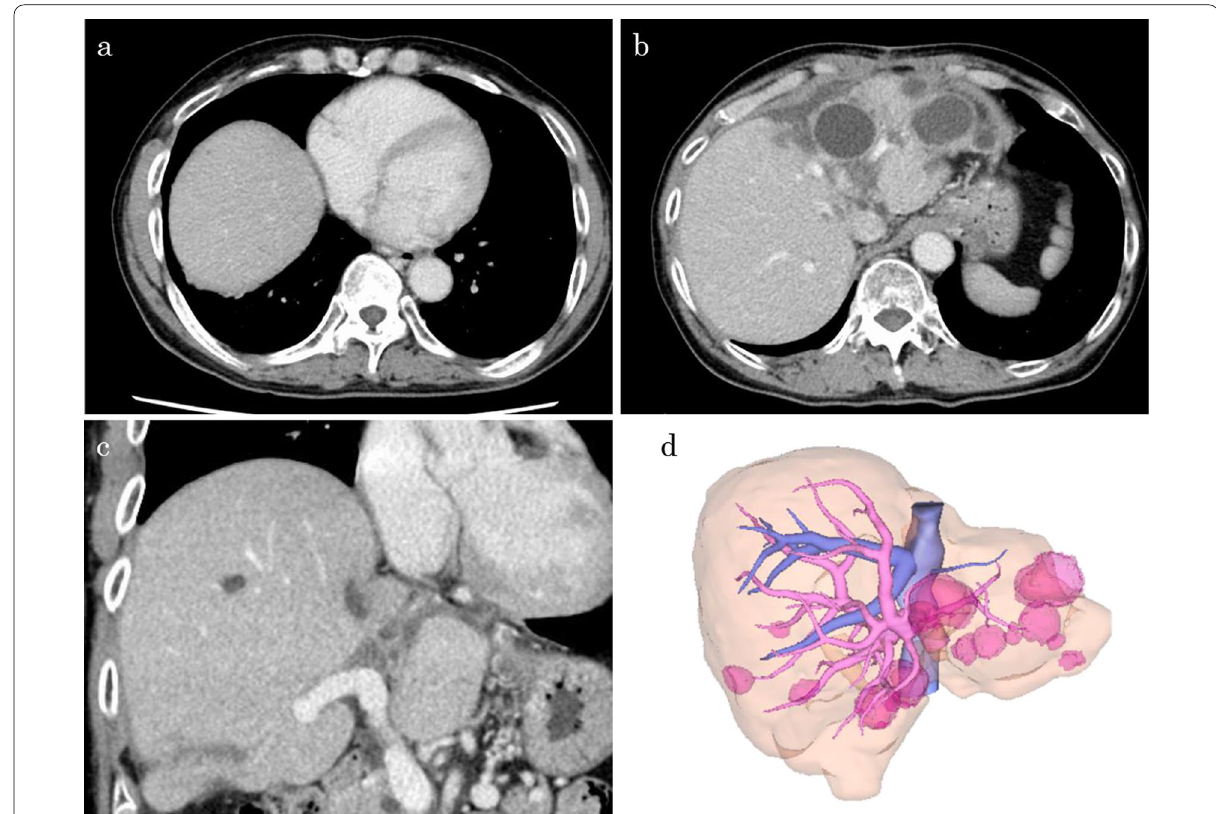
Fig. 5 Computed tomography performed 6 months after the surgery reveals no recurrence of the right heart decompression ( a ), inferior vena cava stenosis ( b ), or portal vein stenosis ( c ). The 3D reconstructed image shows the disappearance of the cyst near the IVC and RHV ( d